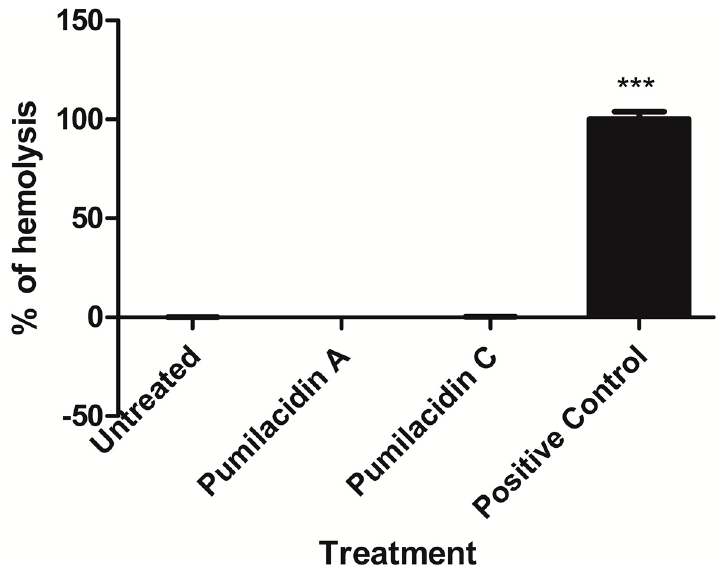
Figure 4. Effect of pumilacidins on hemolytic activity in red blood cells (RBCs). Red blood cells were incubated with pumilacidins at a concentration of 10 μ M for 24 h. Data represent the percentage of hemolysis relative to 0.1% Triton as a positive control (100%) of one representative experiment run in triplicate. *** p < 0.001.